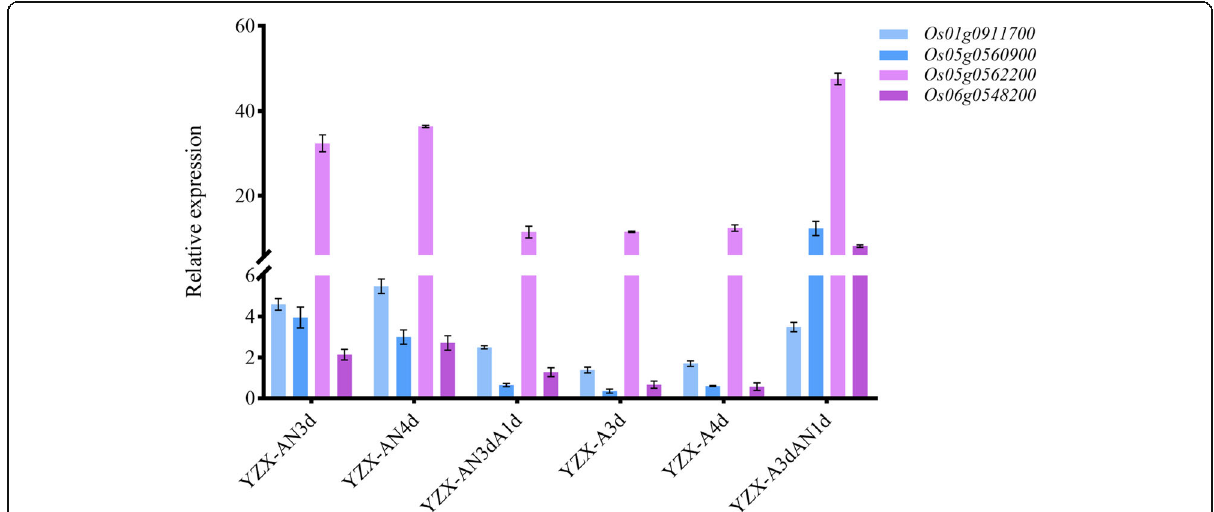
Fig. 7 qRT-PCR expression profile of four most promising candidate genes in different oxygen environments. Values are the means ± standard errors ( n = 3). A is for aerobic environment, AN is for anaerobic environment, AN3dA1d is for anaerobic environment and A3dAN1d is for aerobic environment and anaerobic